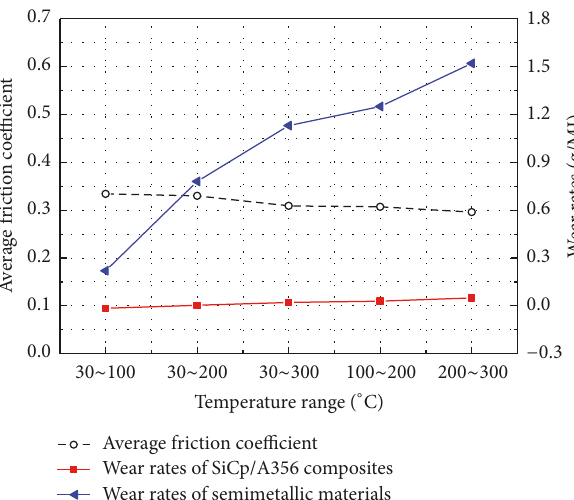
Figure 5: The average friction coefficient and wear rates for different temperature